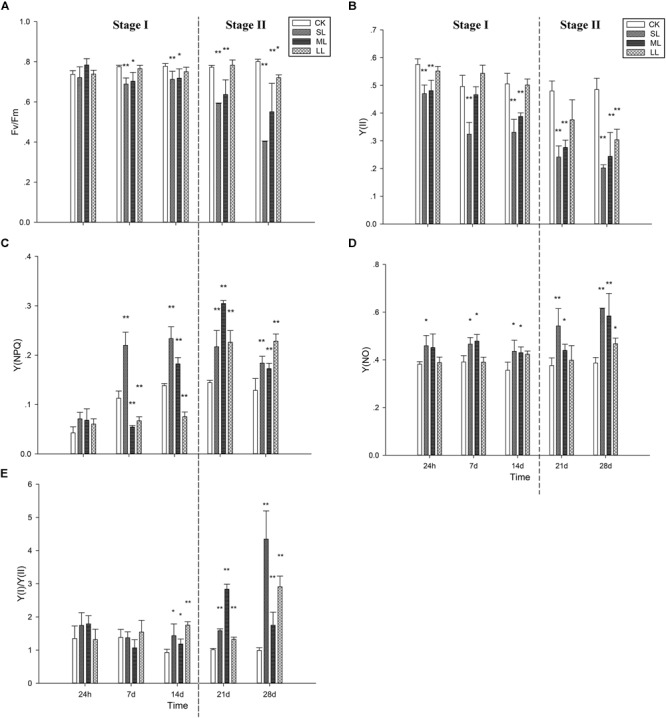
Variations of (A)
Fv/Fm, (B) the effective quantum yield of PSII [Y(II)], (C) the quantum yield of the regulated energy dissipation in PSII [Y(NPQ)], (D) the quantum yield of non-regulated energy dissipation in PSII [Y(NO)], and (E) the ratio of Y(I) to Y(II) in U. prolifera under different climate conditions. ∗Indicates significant difference between treatment and CK groups (P < 0.05). ∗∗Indicates significant difference between treatment and CK groups (P < 0.01). Experiments were performed in triplicate, and the data are the mean of three independent experiments (±SD).